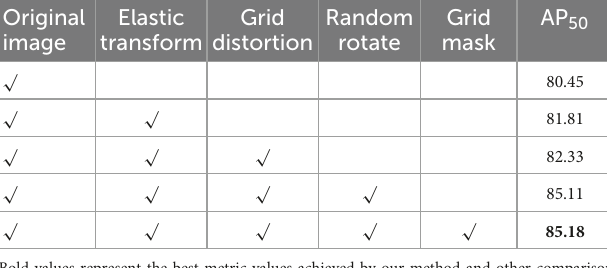
TABLE 2 Performance improvement on various augmentations. Original